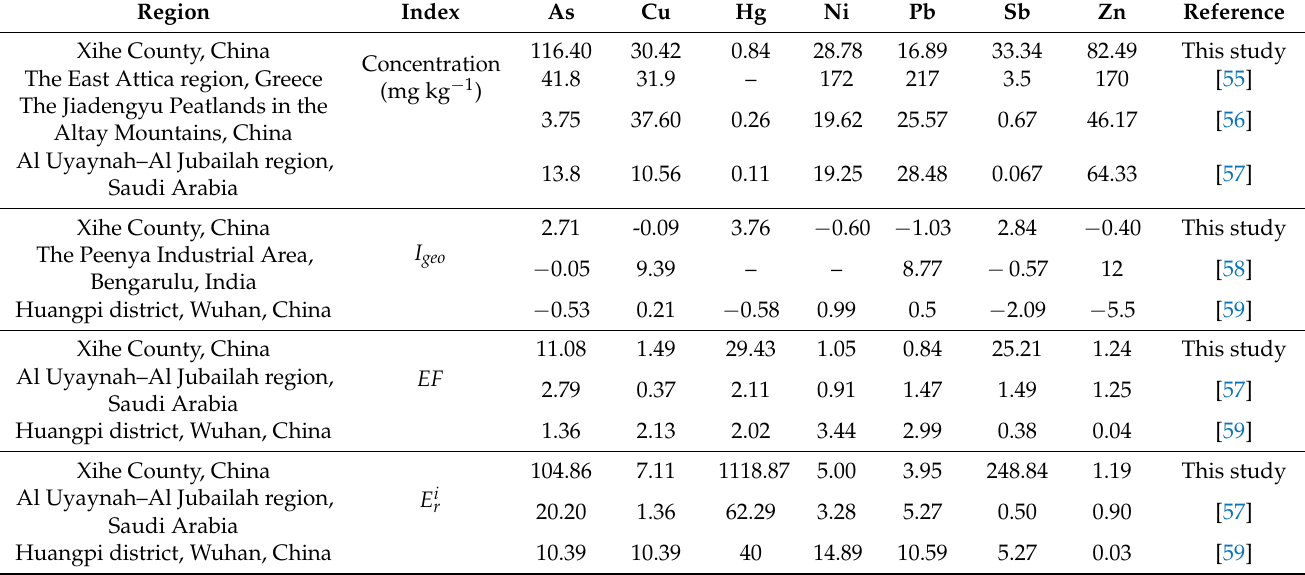
Table 3. Comparison of PTE concentrations, I geo , EF and E i r in soil from different regions of the world.